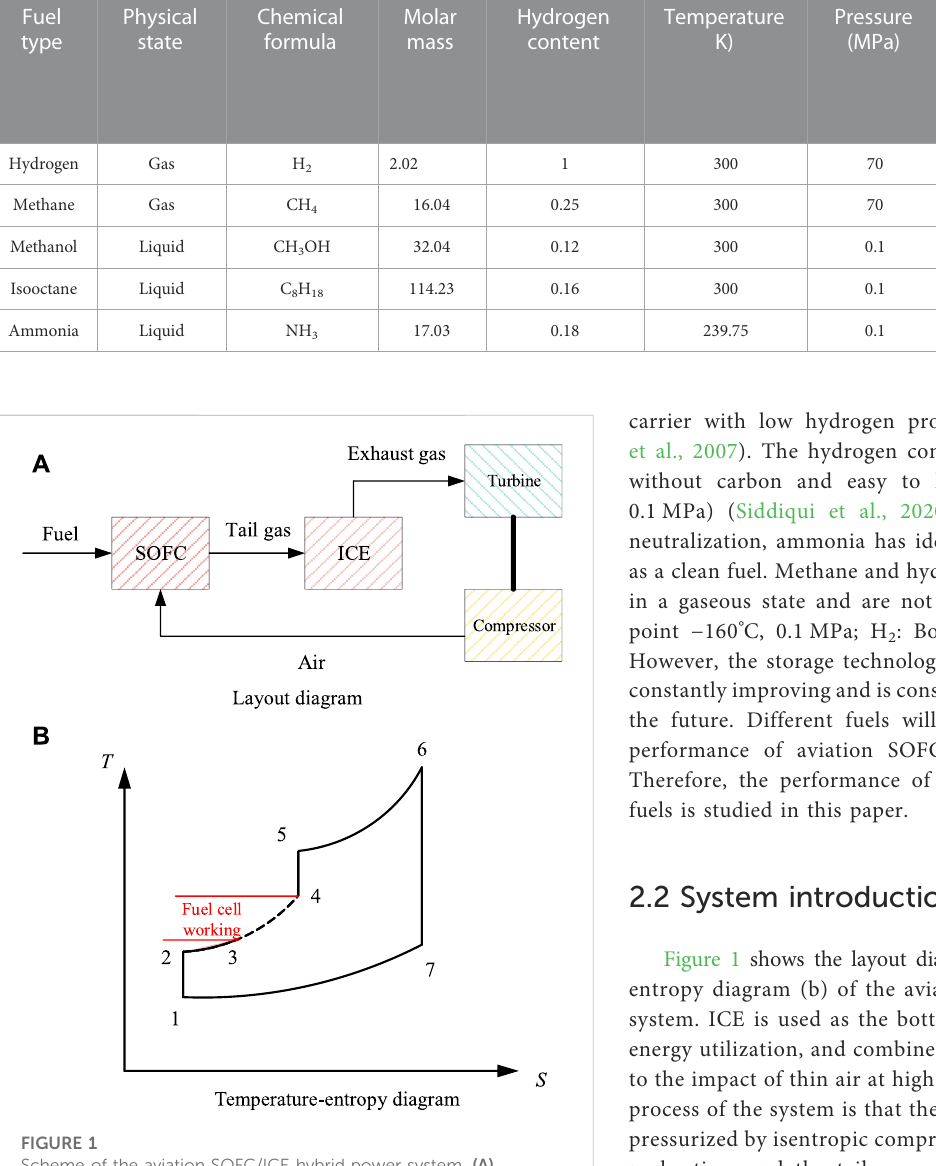
FIGURE 1 Scheme of the aviation SOFC/ICE hybrid power system. (A) Layout diagram. (B) Temperature-entropy